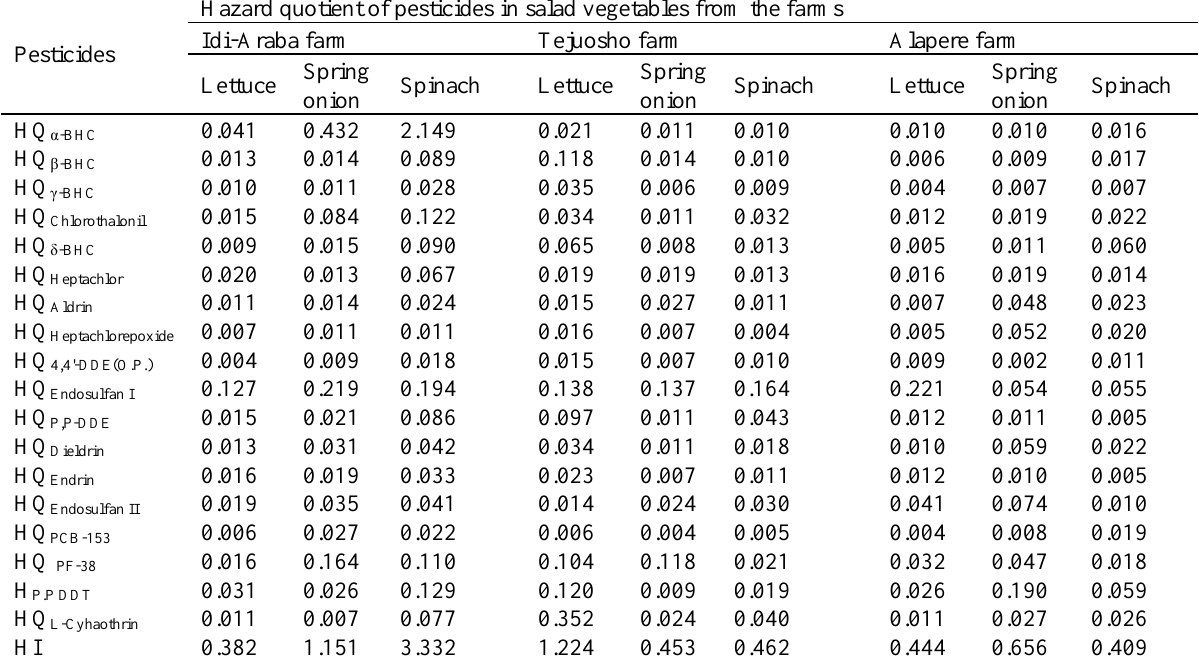
Spring Spinach onion